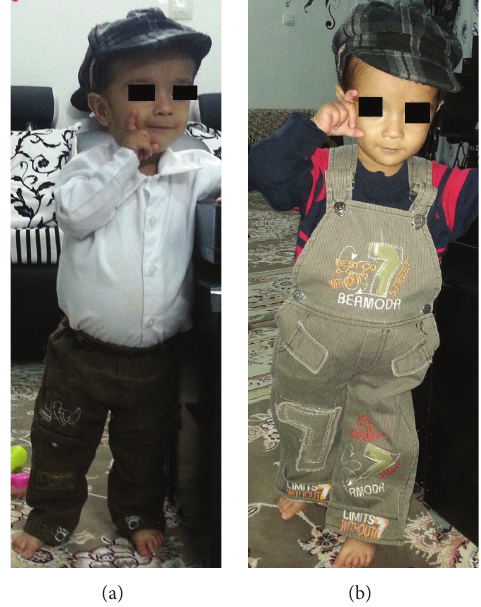
Figure 1: (a) and (b) Note the prominent forehead and cheeks, hypertelorism and broad nasal root, short stature, and abdominal distention of the child.